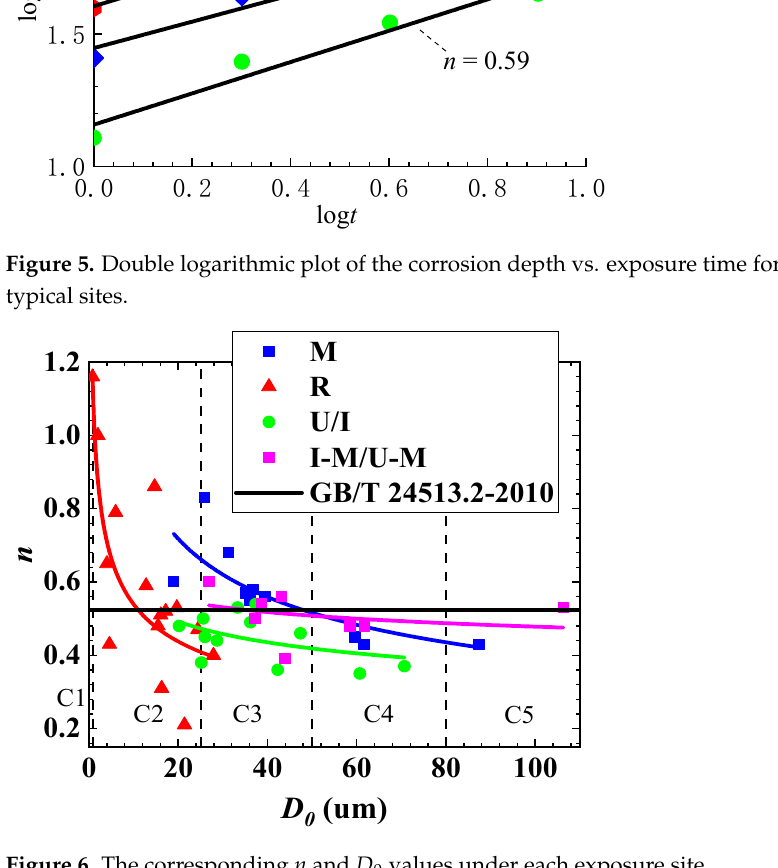
Figure 6. The corresponding n and D 0 values under each exposure site.